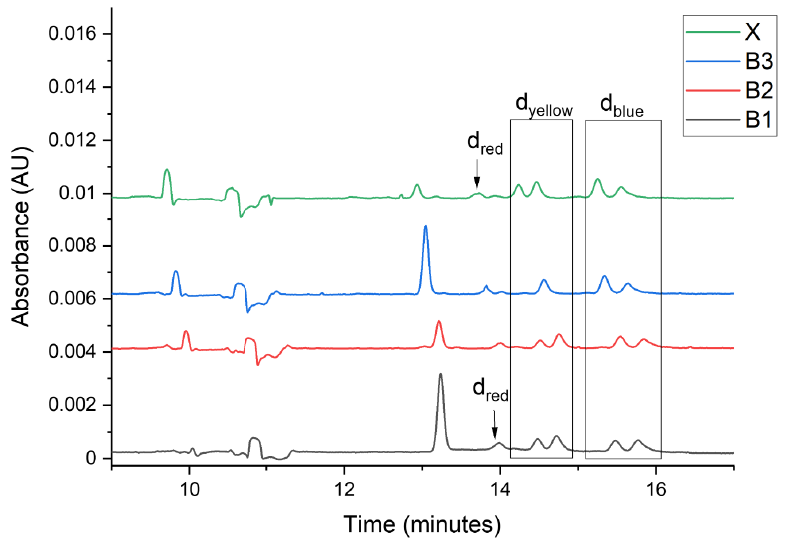
Figure 4. Fragments of PDA views registered for samples B1 – B3, and X. Dye signals are marked on the top, by the orange arrows.